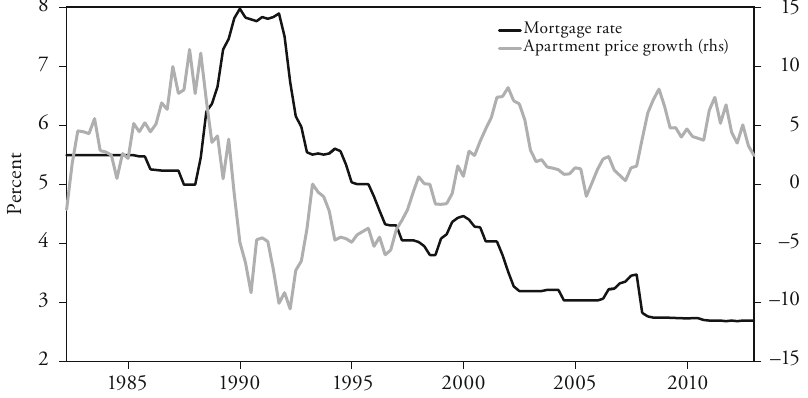
Figure 17: Swiss Apartment Price Growth and Mortgage